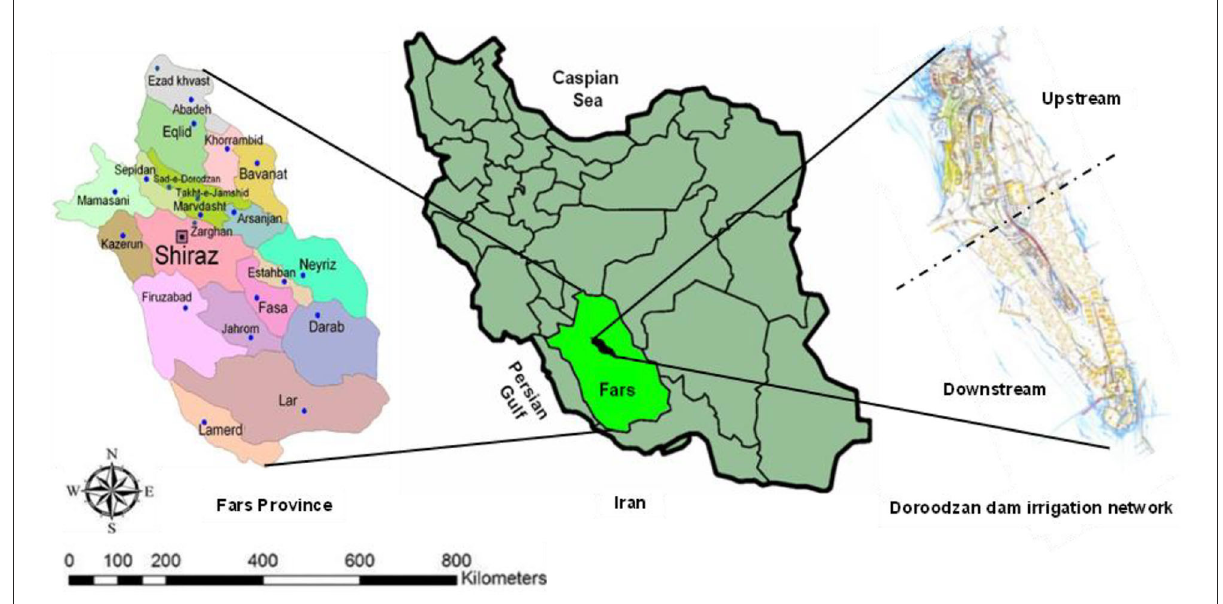
FIGURE2 A general map of Iran illustrating the location of the study area.